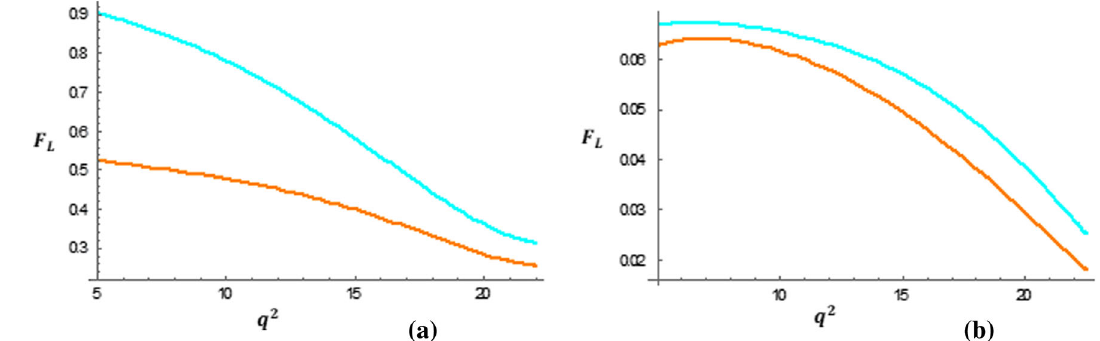
Fig. 6 a B s → ϕμ − τ + , b B s → ϕ e − μ + within allowed kinematic region of q 2 using the bound of NP